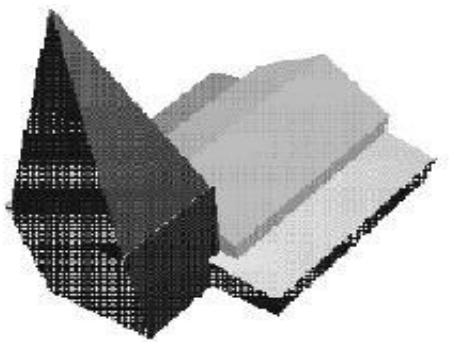
Fig.3- 3D Building model from one eye stereo